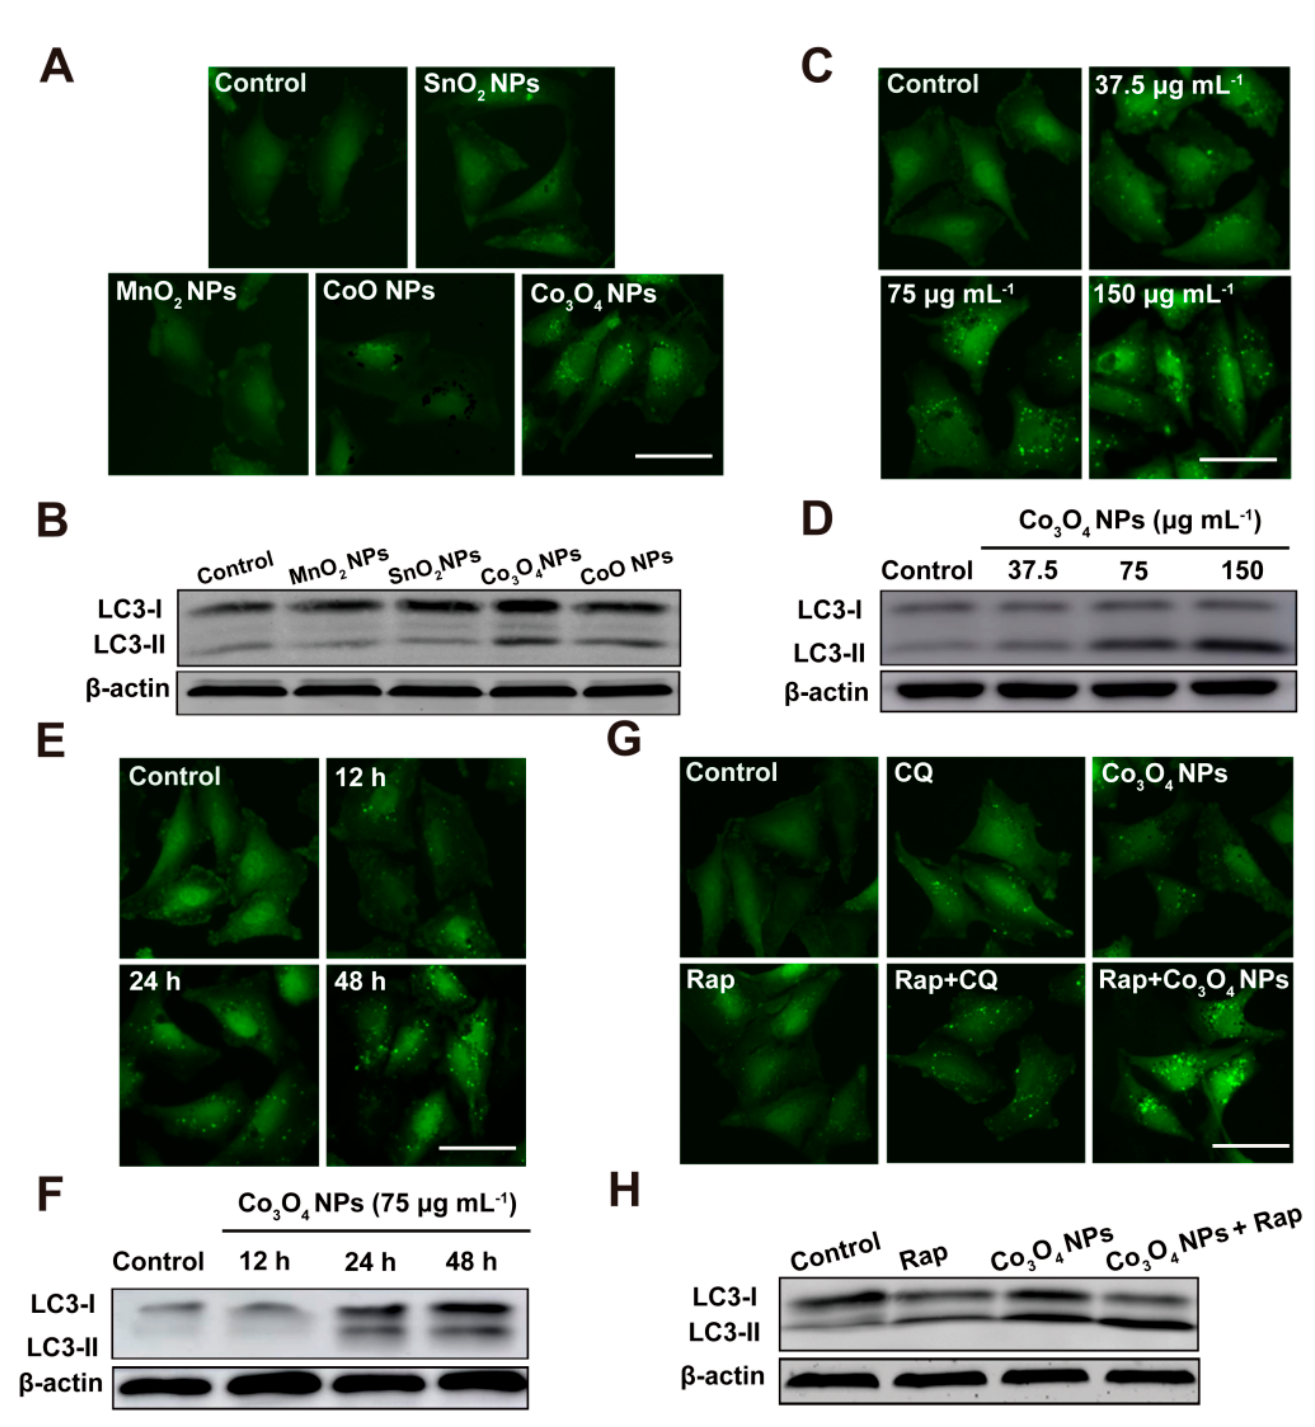
Figure 3. Co 3 O 4 NPs treatment increases autophagosome formation and autophagy-related protein expression in U-87 MG cells. ( A ) Fluorescent imaging and ( B ) representative Western blots of U-87 MG/GFP-LC3 cells incubated with different kinds of NPs for 24 h. ( C ) Fluorescent imaging and ( D ) representative Western blots of U-87 MG/GFP-LC3 cells incubated with different concentrations of Co 3 O 4 NPs for 24 h. ( E ) Fluorescent imaging and ( F ) representative Western blots of U-87 MG/GFP-LC3 cells with Co 3 O 4 NPs for different durations. ( G ) Fluorescent imaging and ( H ) representative Western blots of U-87 MG/GFP-LC3 cells incubated with Co 3 O 4 NPs and/or Rap for 24 h. Green puncta represent autophagosomes. Scale bar = 50 μ m. Reproduced with permission from [20]. Copyright Elsevier, 2021.